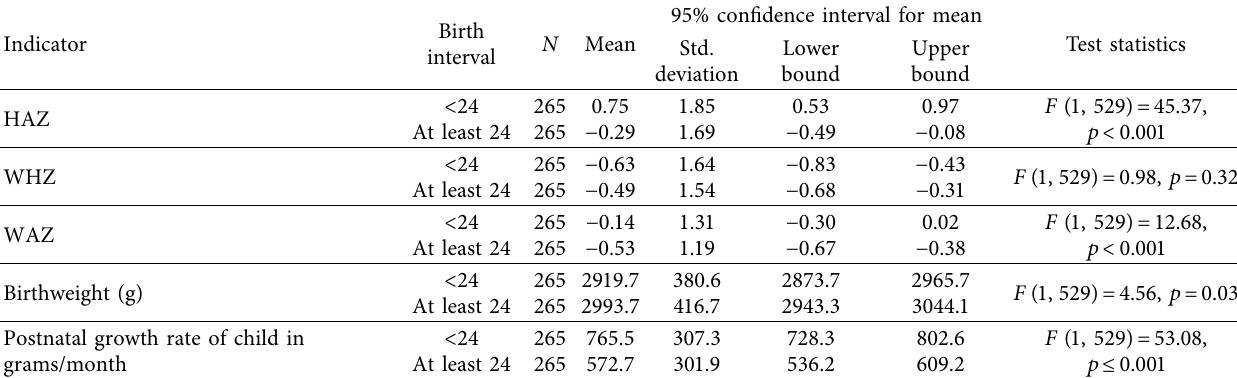
Table 2: Comparison of child growth indices according to the birth interval (unadjusted